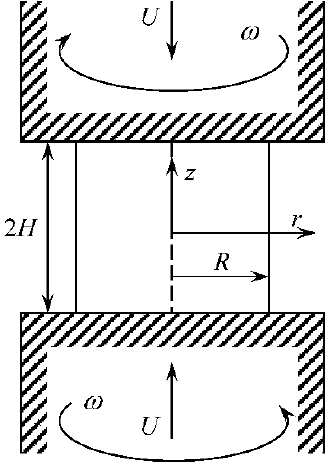
Figure 1. Schematic diagram of the process.